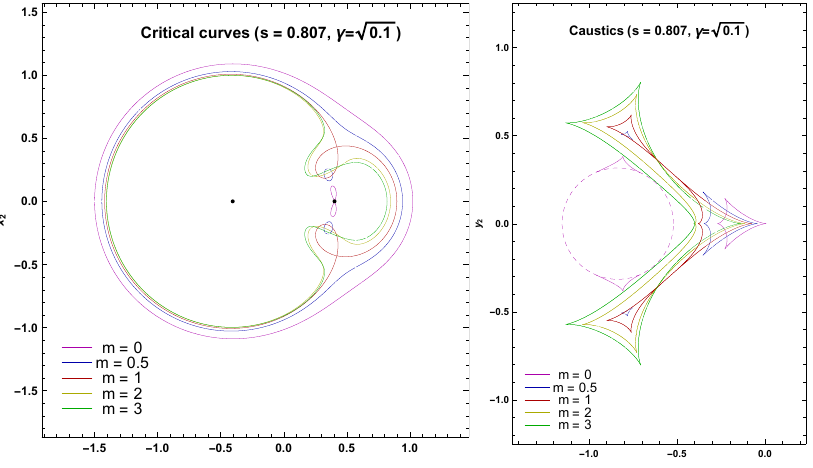
Figure 10. Critical curves and caustics in the unequal-strength binary, close-intermediate transition. Dashed magenta circle indicates the pseudocaustic for m =